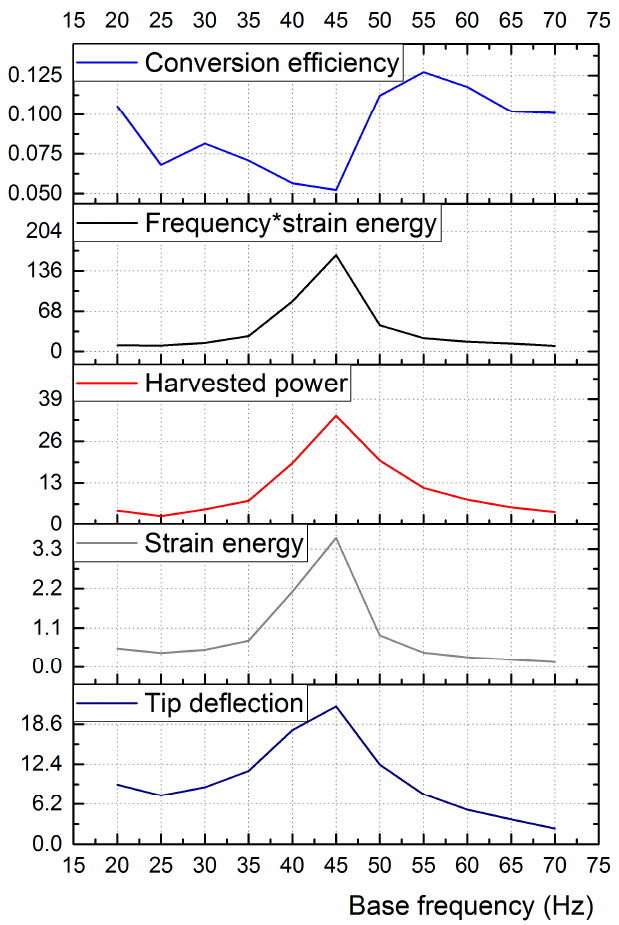
Figure 17. Correlation of the harvested power to the product of (oscillation frequency) × (strain energy) at the oscillation extrema (base excitation only).